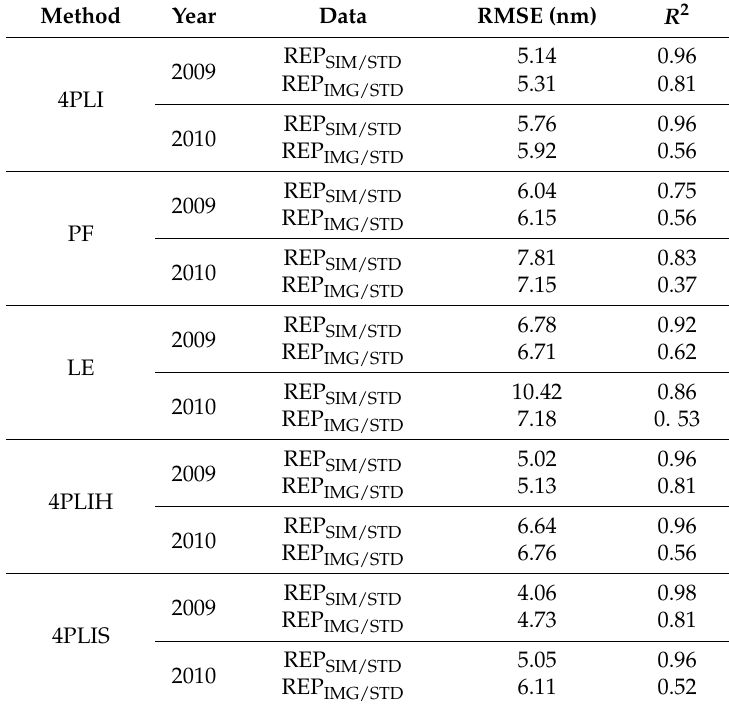
Table 2. Comparison of RMSE and R 2 values of REP SIM/STD and REP IMG/STD (For HyMap: 4PLI, PF, LE, 4PLIH and for simulated S2 data: 4PLIS